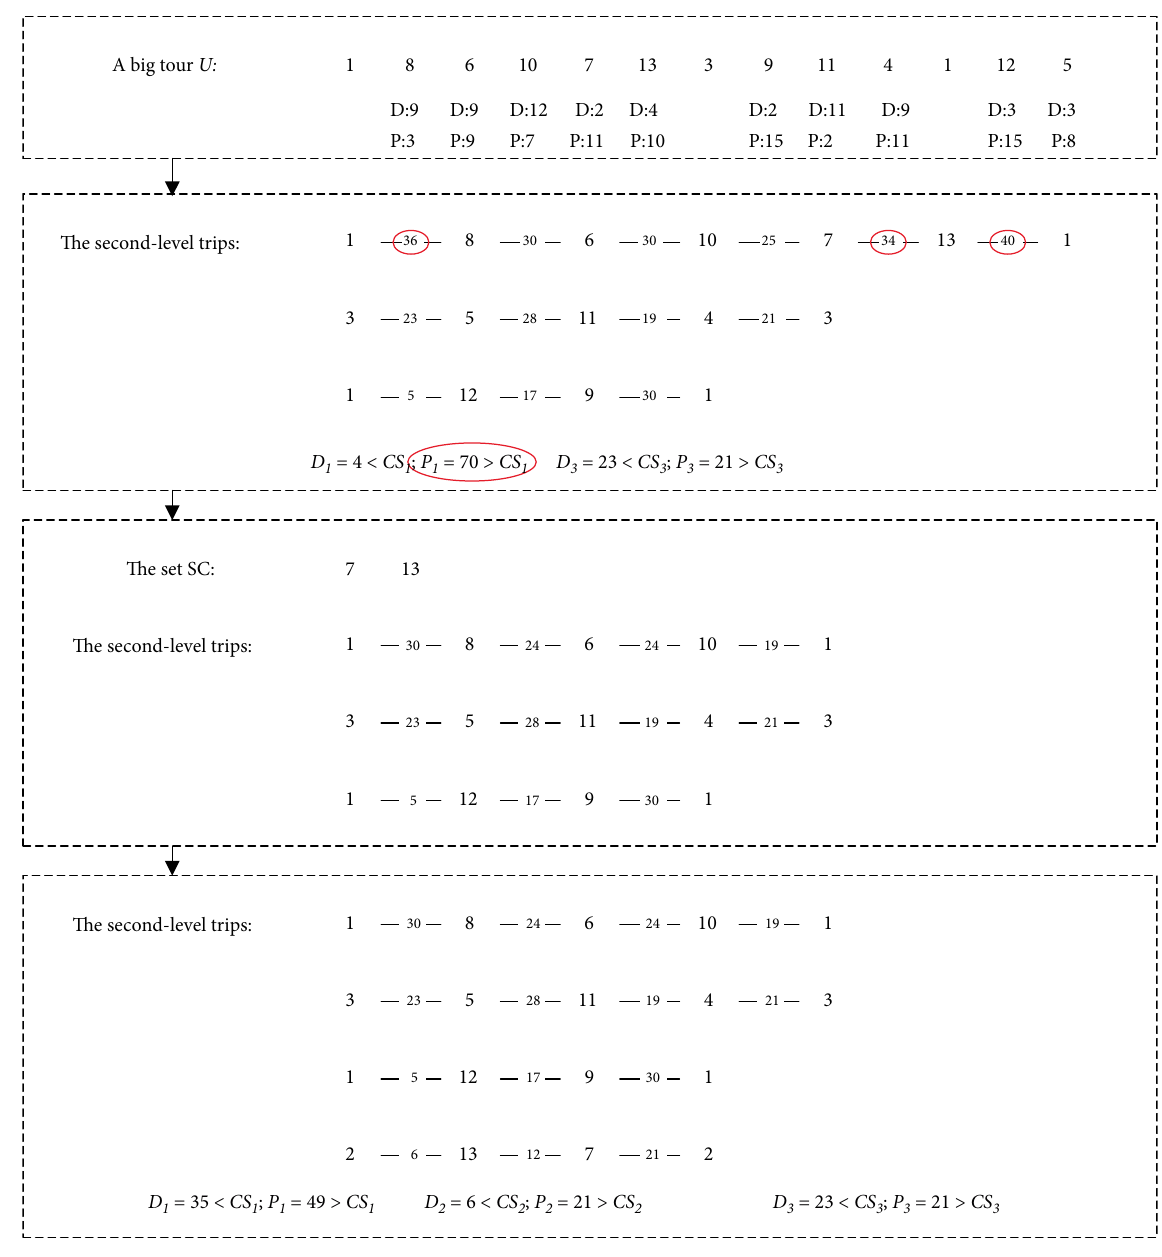
Figure 9: Examples of repair